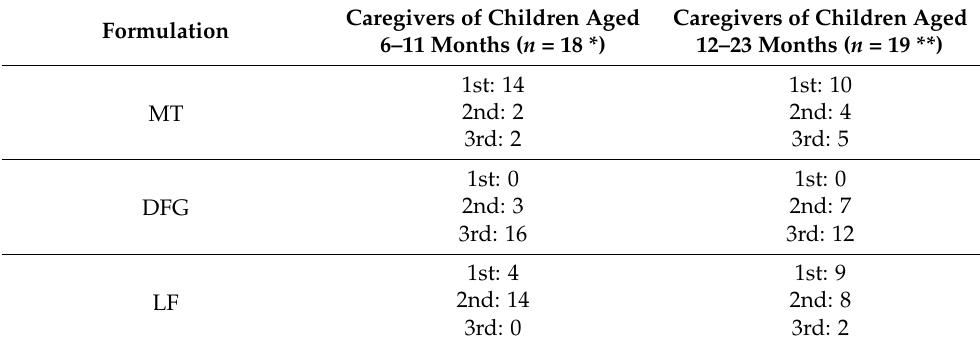
Table 4. Ranking of formulations by the caregivers based on their intention to use them in the future.